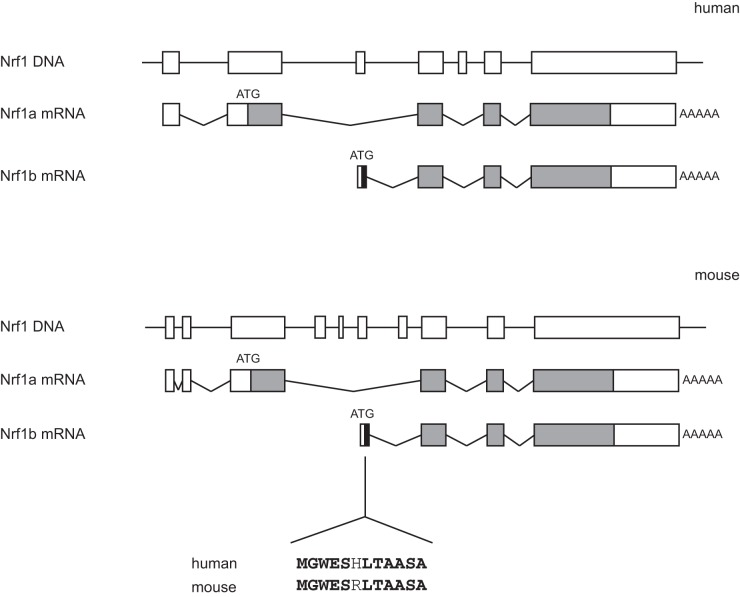
Nrf1b encodes a novel Nrf1 protein.Schematic diagram of human and mouse Nrf1 genomic sequences, and depiction of Nrf1a and Nrf1b transcripts. Solid and open boxes represent coding regions and untranslated regions, respectively. Solid lines represent introns and 5′-flanking regions.